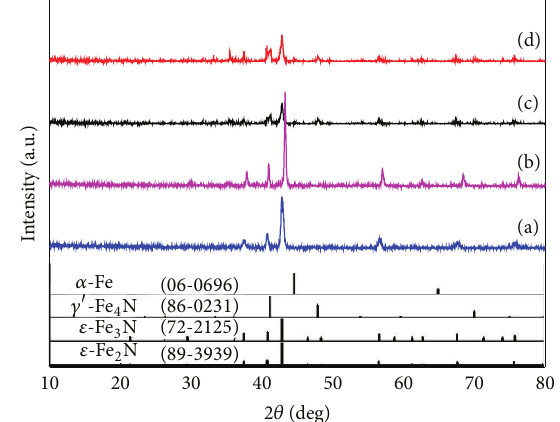
Figure 3: XRD patterns of the iron nitride samples. (a) FN-1, (b) FN-2, (c) FN-3, and (d)